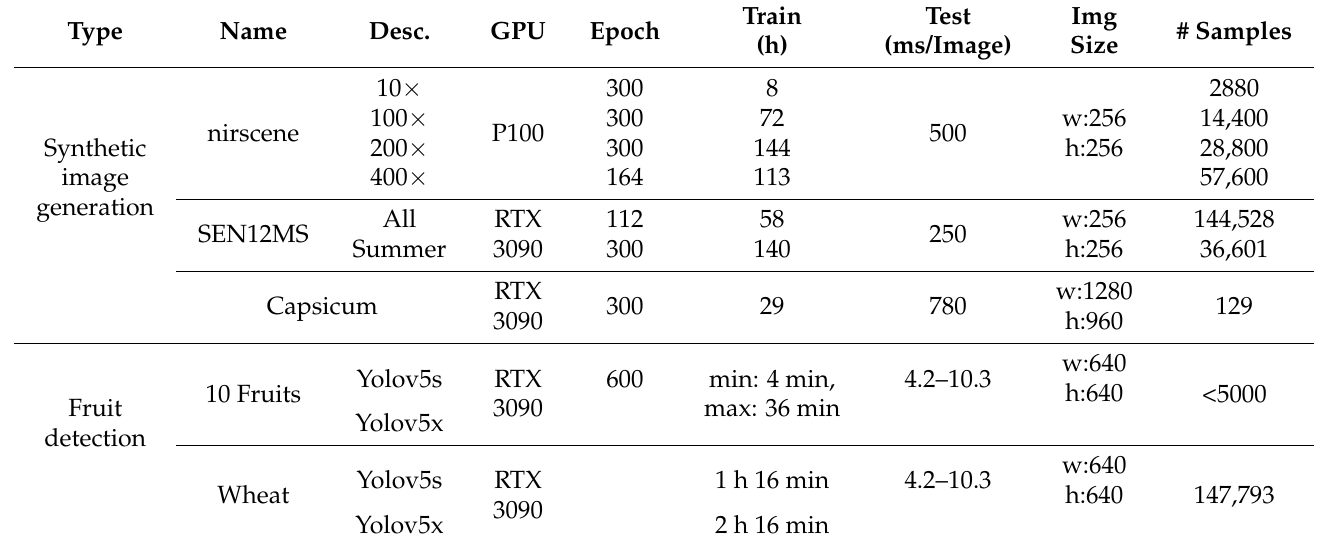
Table 4. Train/inference summary